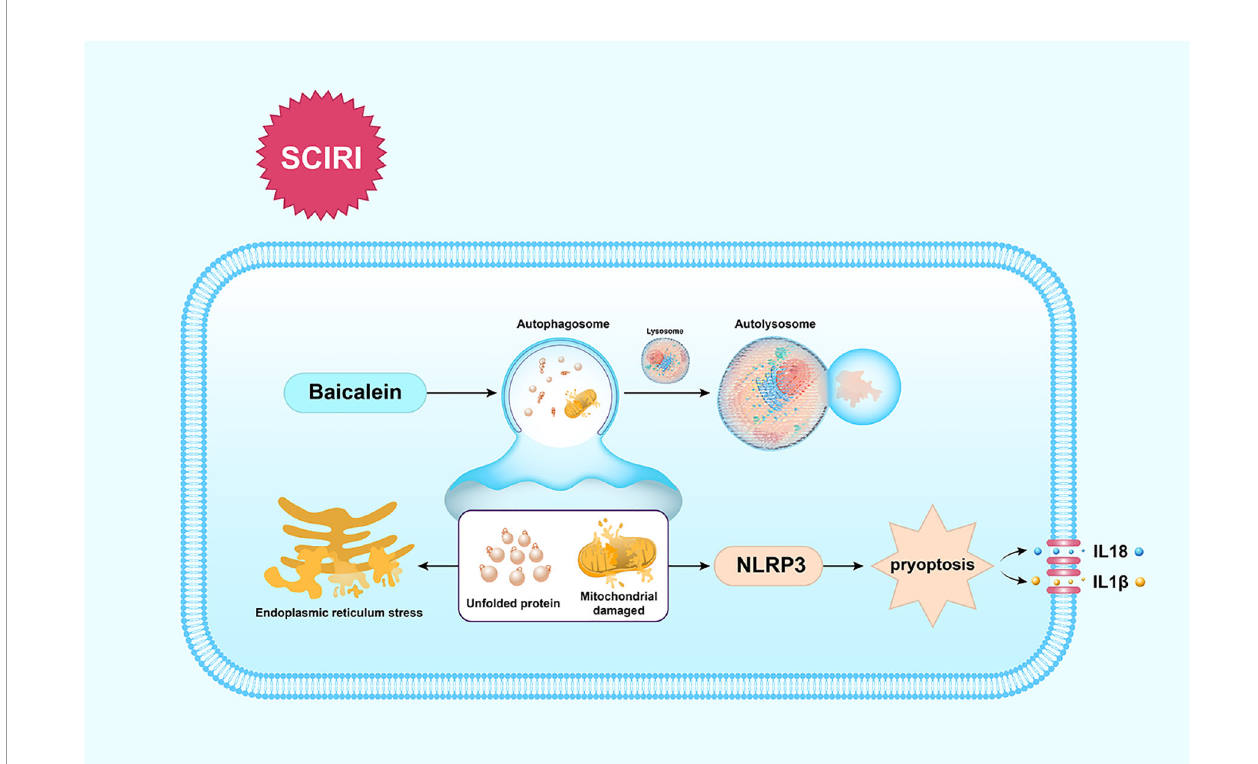
FIGURE 6 | Schematic illustration of the proposed molecular mechanism by which baicalein facilitates functional recovery after spinal cord ischemia-reperfusion injury (SCIRI) by activating autophagy and subsequently reducing ER stress-induced apoptosis and attenuating pyroptosis. Spinal cord ischemia-reperfusion (I/R) injury leads to the accumulation of unfolded proteins in the endoplasmic reticulum (ER) and mitochondrial damage. Autophagy is then activated by baicalein to contribute to the elimination of damaged mitochondria and unfolded proteins by forming autolysosomes with lysosomes. Subsequently, ER stress-induced apoptosis and pyroptosis are inhibited, which further results in the promotion of functional